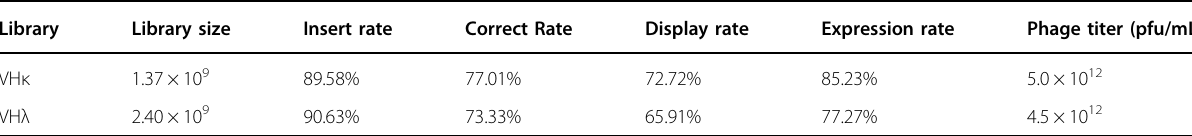
Table 1 Characteristics of the constructed phage-display libraries.